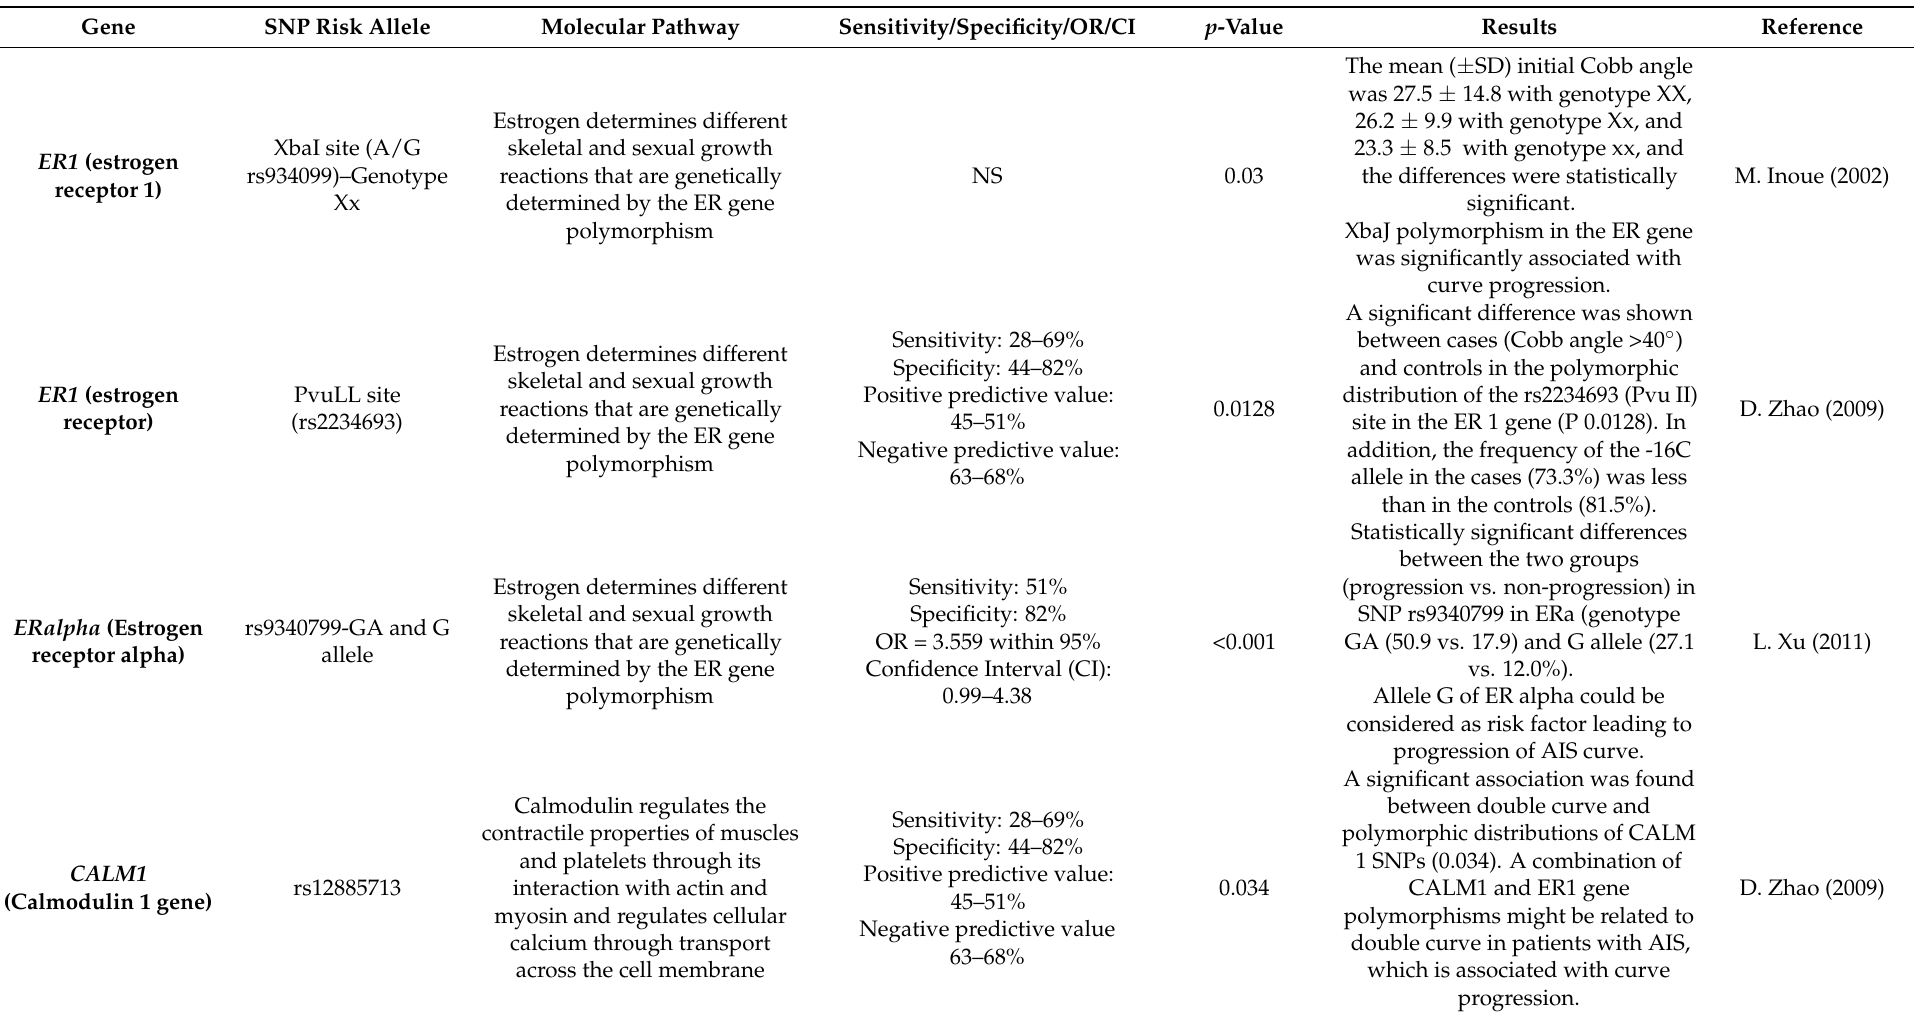
Table 2. The reported SNPs with statistically significant evidence in AIS curve progression (NS = non-specified, OR = odds